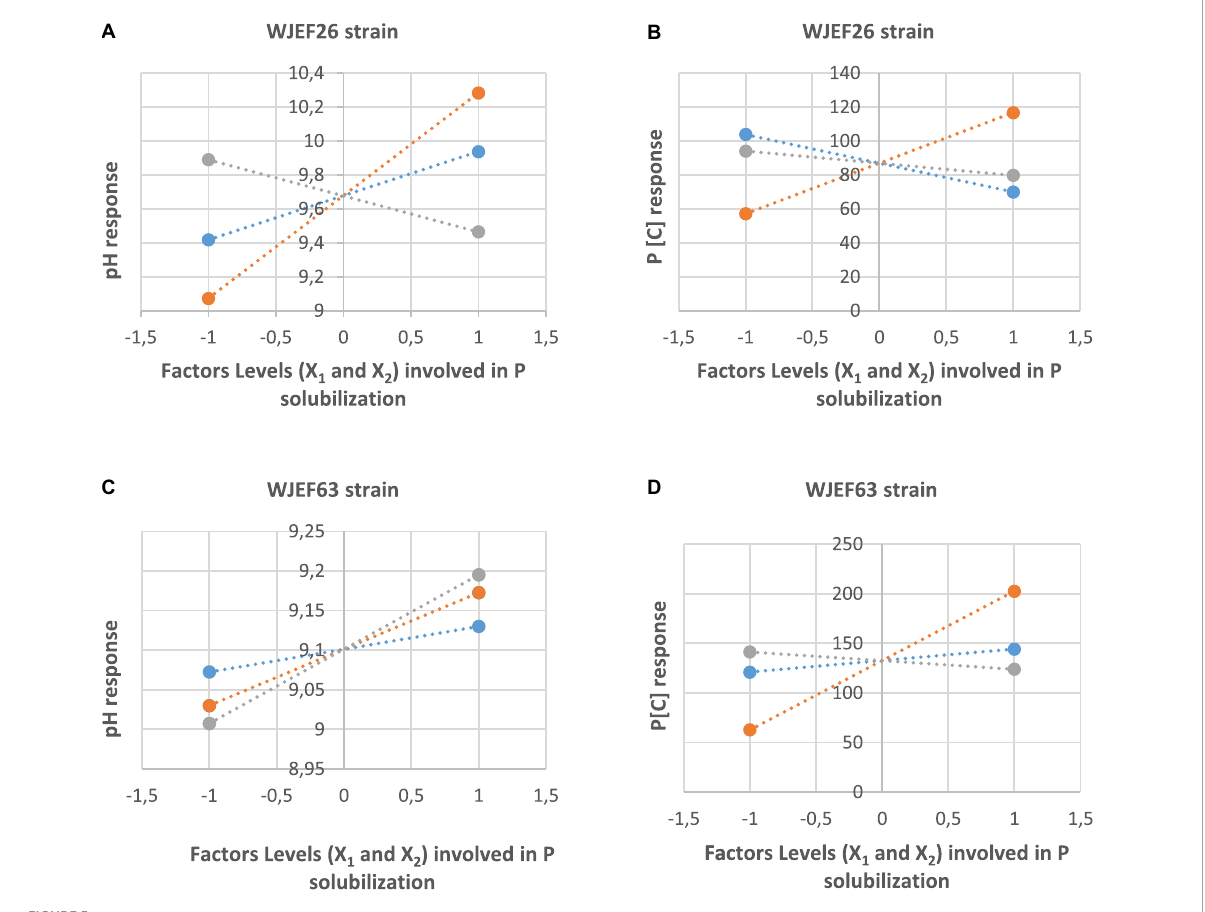
FIGURE5 (A) Effects of studied factors (X 1 and X 2 ) and their interaction on pH medium in the presence of WJEF26 strain. (B) Effects of studied factors (X 1 and X 2 ) and their interaction on P[C] in the presence of WJEF26 strain. (C) Effects of studied factors (X 1 and X 2 ) and their interaction on pH medium in the presence of WJEF63 strain. (D) Effects of studied factors (X 1 and X 2 ) and their interaction on P[C] in the presence of WJEF63 strain.